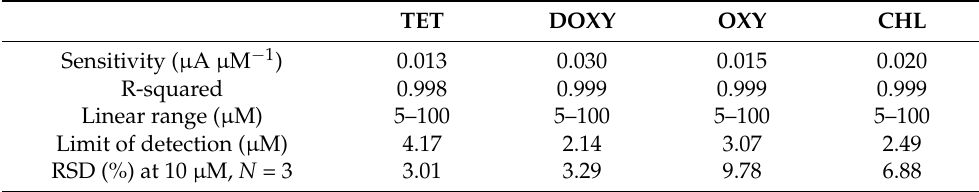
Figure 4. Baseline-corrected SWV for ( a ) TET, ( b ) DOXY, ( c ) OXY, and ( d ) CHL at pH 9 in Britton Robinson buffer in a range from 1 to 100 µM using carbon SPE. Corresponding calibration curves of the four TCs ( e ) TET, ( f ) DOXY, ( g ) OXY, and ( h ) CHL showing the peak current versus concentration of the different TCs ( N = 3). Table 1. Analytical parameters obtained from calibrations curves of TET, DOXY, OXY, and CHL in a range from 1 to 100 µM concentration and RDS obtained from the reproducibility study (Figure S8).